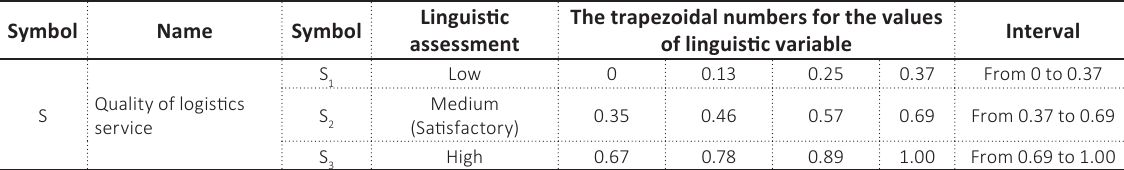
Table 3. General evaluation of the logistics service quality for the developed